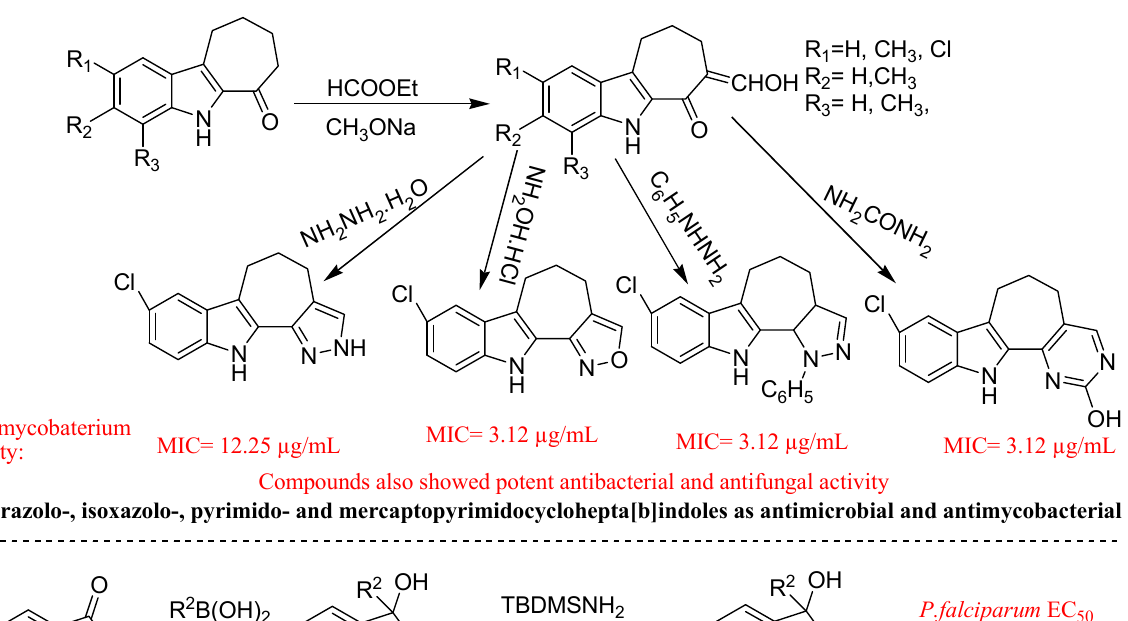
Figure 40. Cyclohepta[b]indoles and